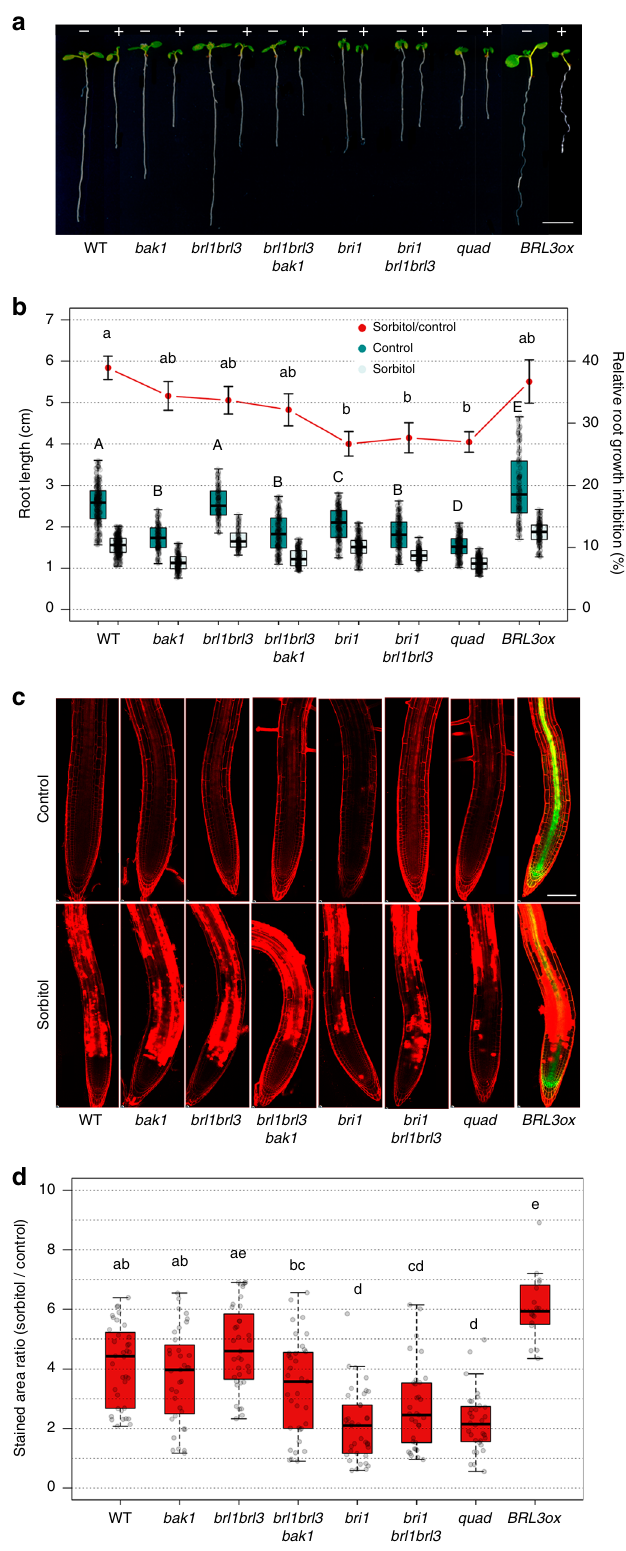
function mutants showed reduced hydrotropic responses com- pared to WT plants. For instance, while no signi fi cant differences were found under control conditions (mock) (Supplementary Fig. 3), the roots of BR receptor mutants grew straighter than WT roots towards sorbitol-containing media (Fig. 2a – c). Interestingly,